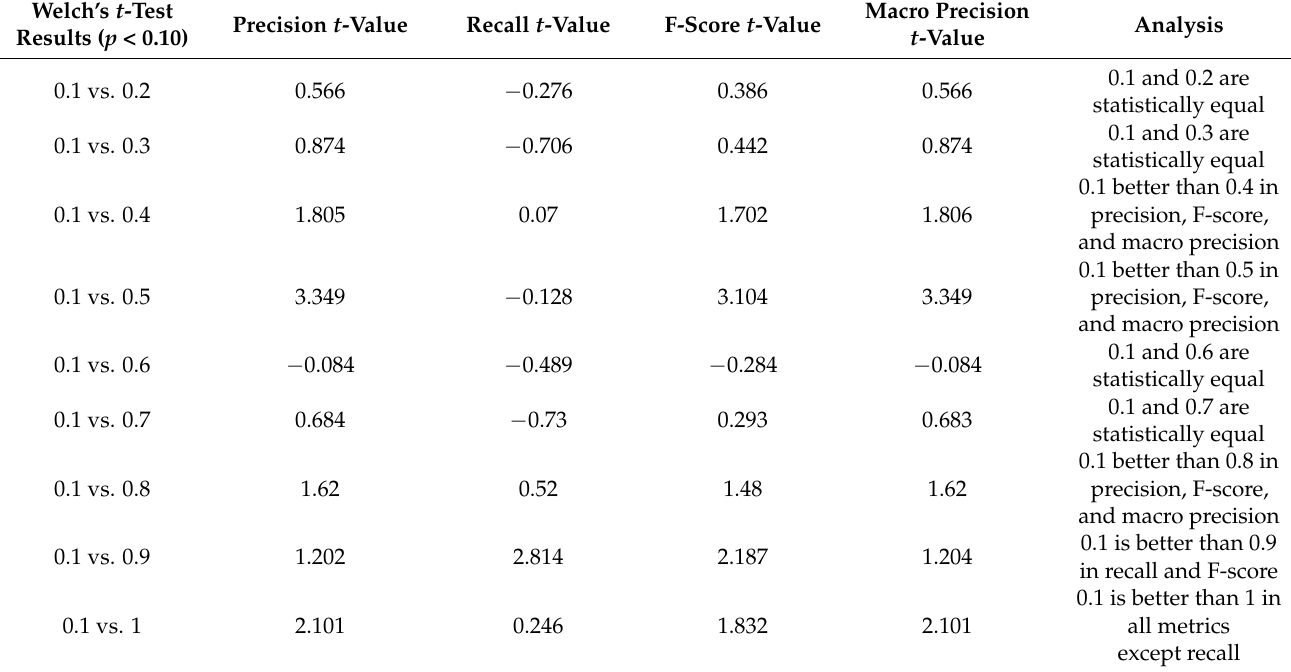
Table 18. Welch’s t -test results: UNSW-NB15: Shellcode—random undersampling after